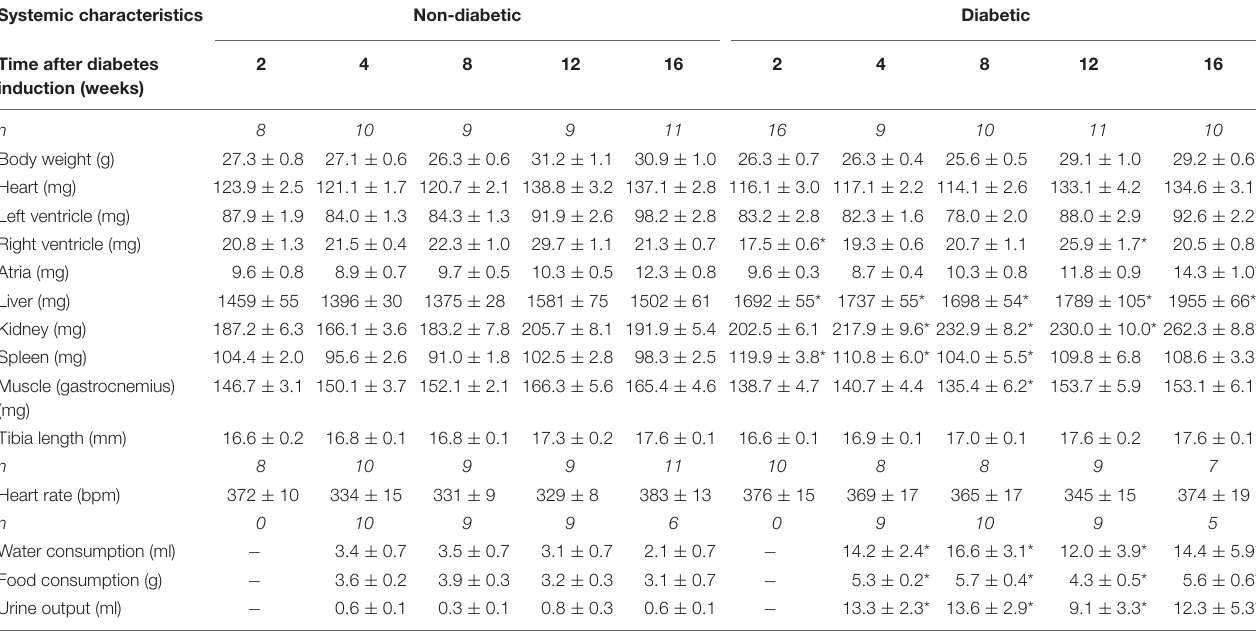
TABLE 1 | Systemic characteristics of diabetic and non-diabetic mice at endpoint. Systemic characteristics Non-diabetic